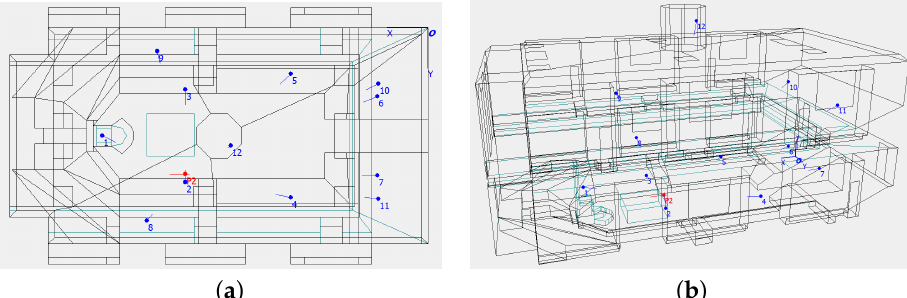
Figure 8. ( a ) An elevation view of the final ODEON model and ( b ) an east-to-west view of the space demonstrating the chosen source as a Member of the Parliament (MP) speaker on the right side of the Speaker’s chair (presented in red), and twelve receiver positions (presented in blue) in several positions on the main floor, galleries and ventilation space, all facing the source.